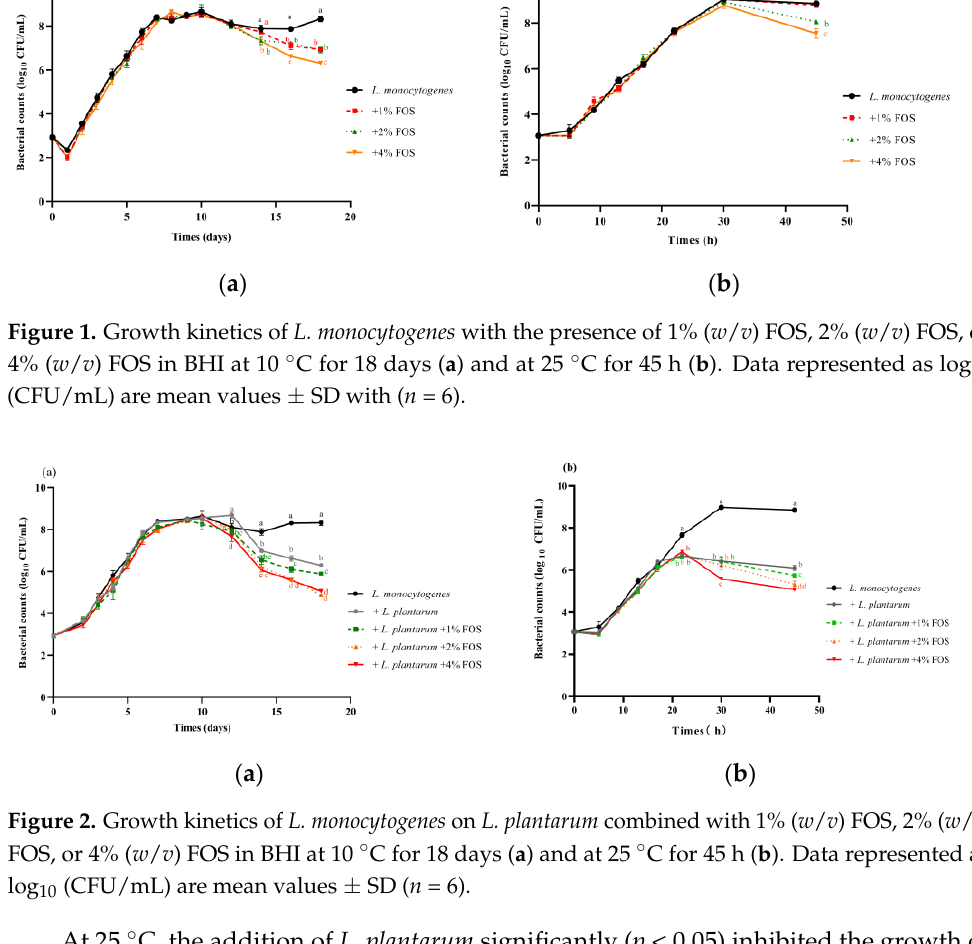
Figure 1. Growth kinetics of L. monocytogenes with the presence of 1% ( w / v ) FOS, 2% ( w / v ) FOS, or 4% ( w / v ) FOS in BHI at 10 °C for 18 days ( a ) and at 25 °C for 45 h ( b ). Data represented as log 10 (CFU/mL) are mean values ± SD with ( n = 6).